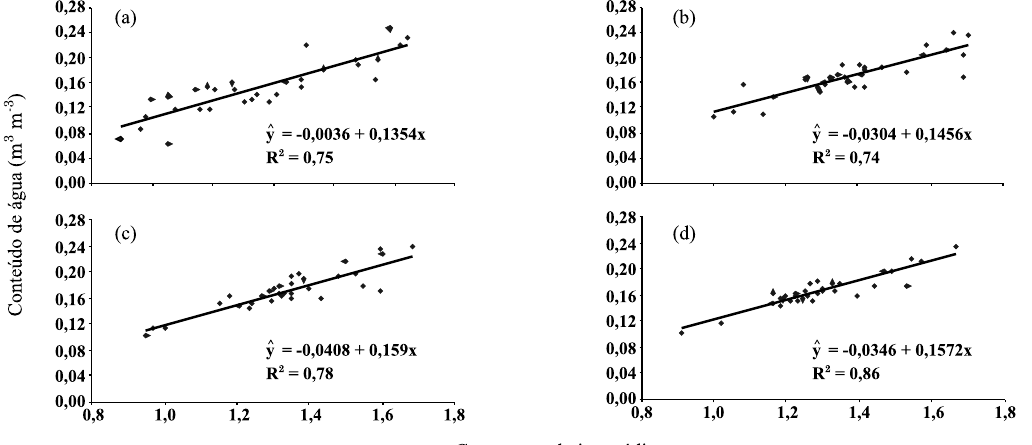
Figura 2. Curvas de calibração da sonda de nêutrons para as profundidades de 0,20 (a), 0,40 (b), 0,60 (c) e 0,80 m